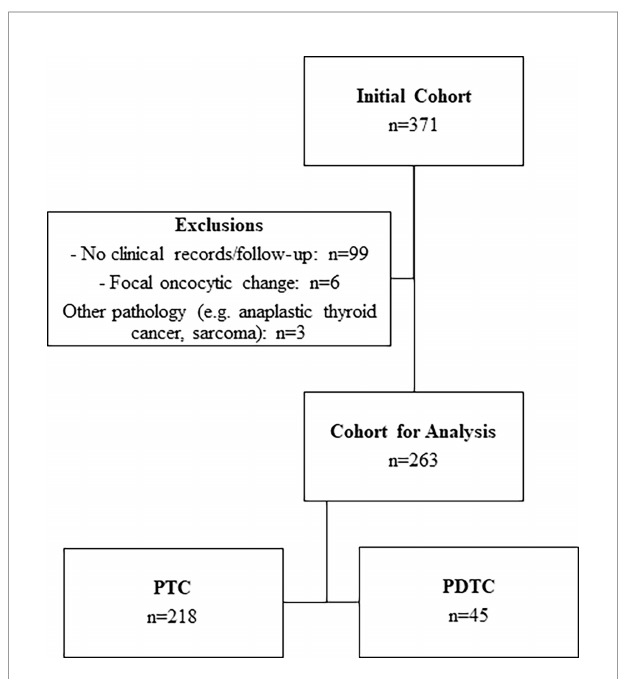
Table 1 . Of the 263 patients, 218 had oncocytic PTC